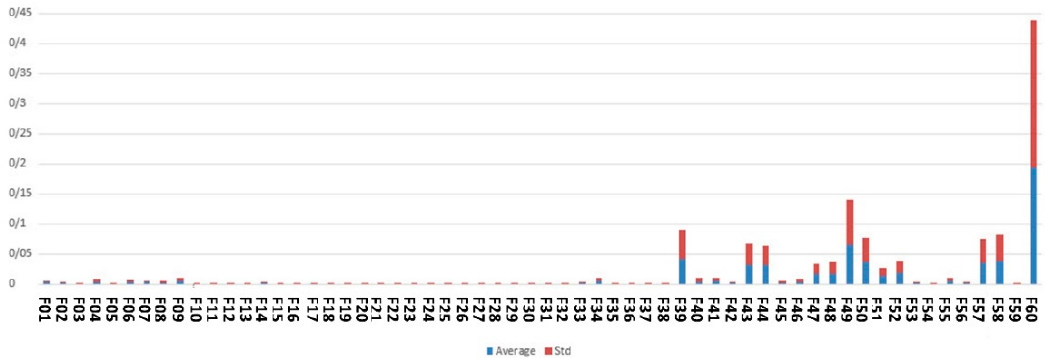
Figure 6. The average and standard deviation of the feature scored based on embedded methods used in this